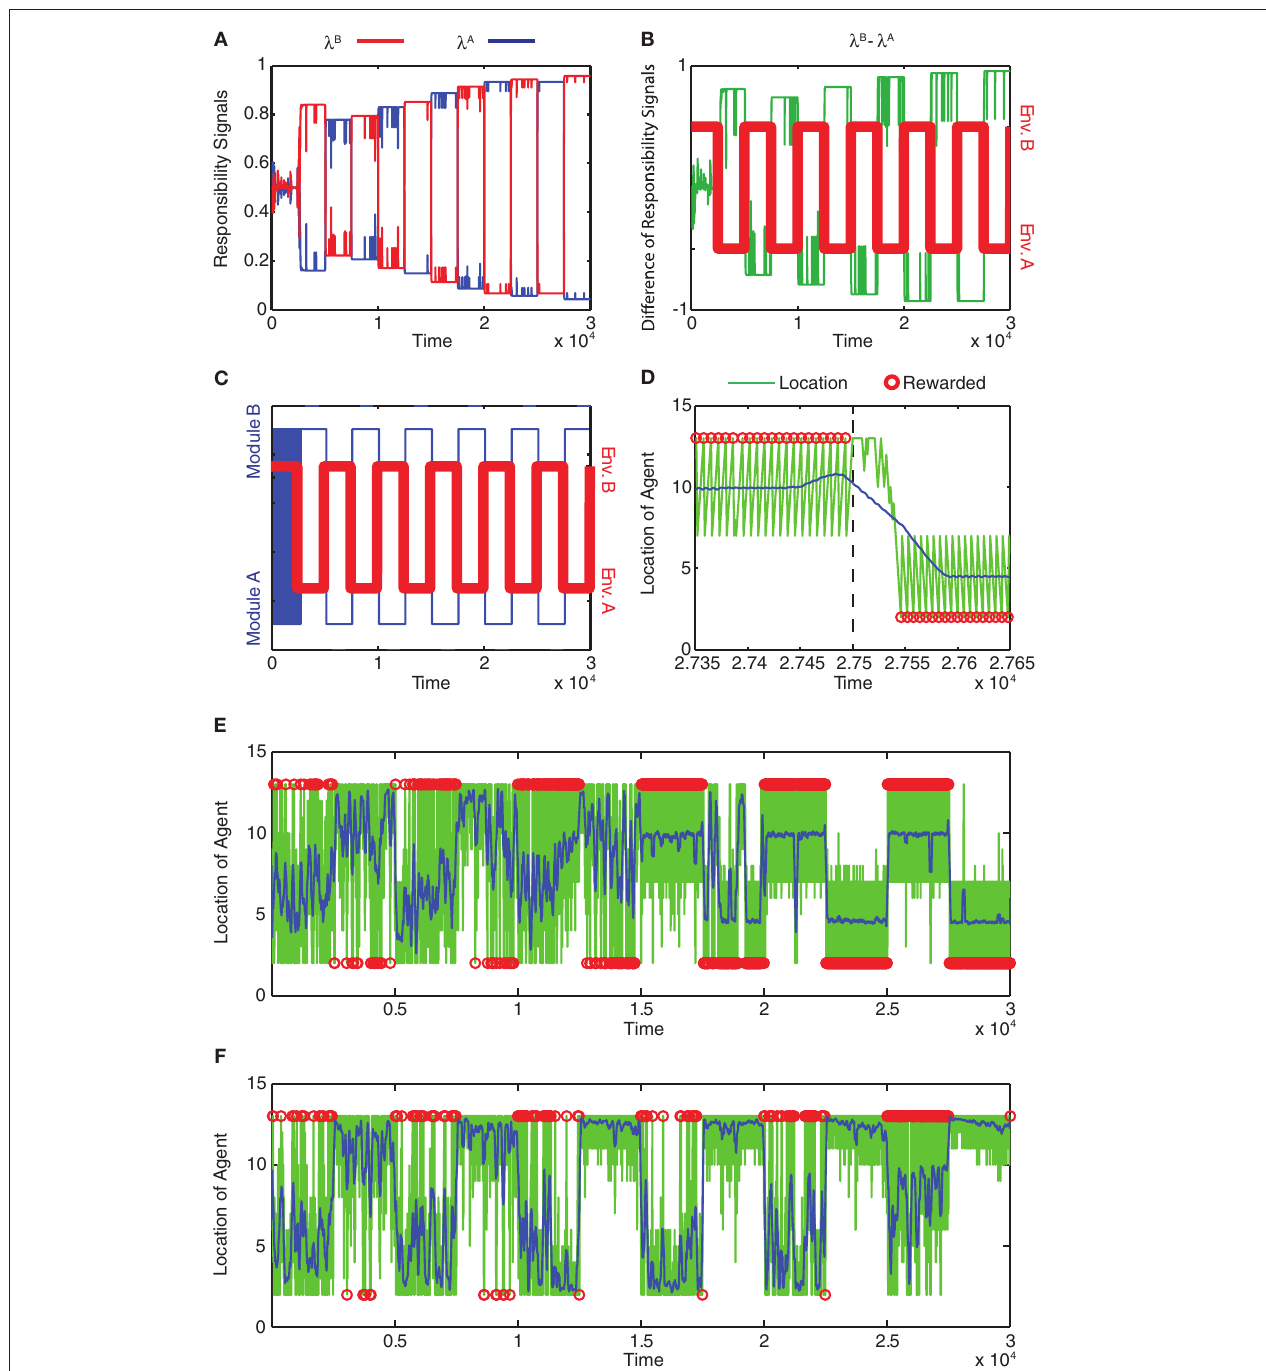
the agent as a function of time late in training, from time 27350 to time 27650 (green line). Blue line indicates location smoothed with a moving average with window of width 100. Red circles indicate the times and locations at which the agent obtained the reward. Environment changes from Env. B to Env. A at time 27500 (dashed line). The module switches from B to A around 27530. (e) Location of the agent as a function of time for the entire training period. Symbols are as in (D) . After learning, the agent can obtain rewards in either terminal, depending on the environment. (F) Failure of learning of normal, non-modular RL. In this case, the model learns to obtain rewards only at s